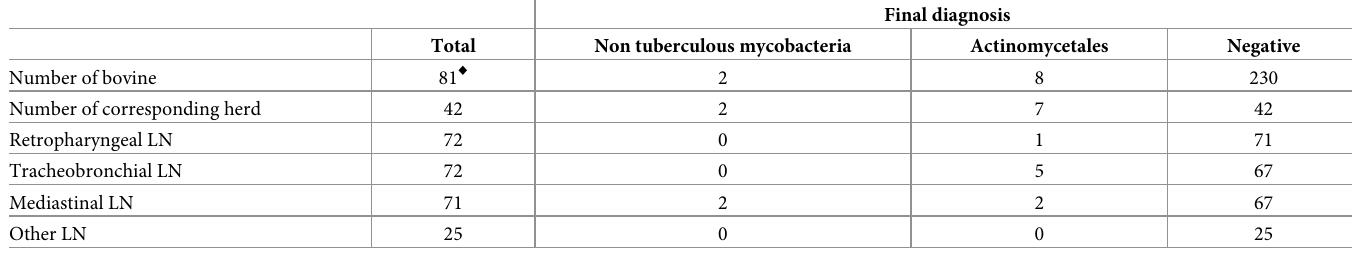
Table 4. Number of histology -/PCR—Samples analysed and final diagnosis (bacteriology or molecular) obtained at the National Reference Laboratory for